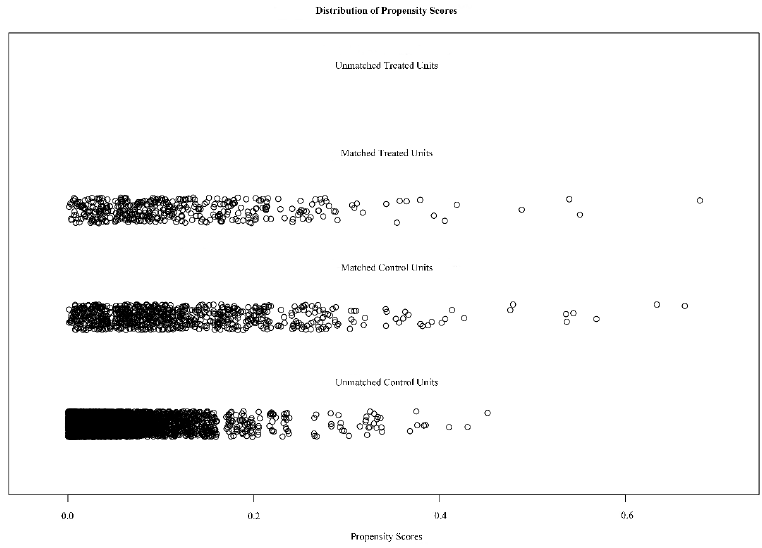
Figure 3. Distribution of propensity scores for the matched and unmatched treatment and control subjects with a ratio of 1:2.